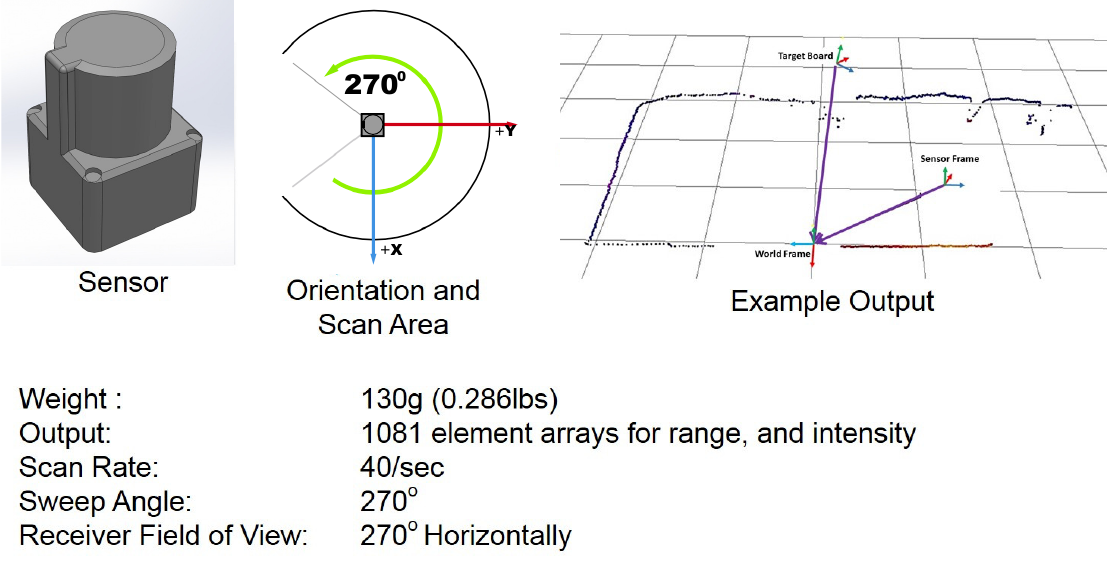
Figure 1. Hokuyo UST-20LX sensor summary, adapted from